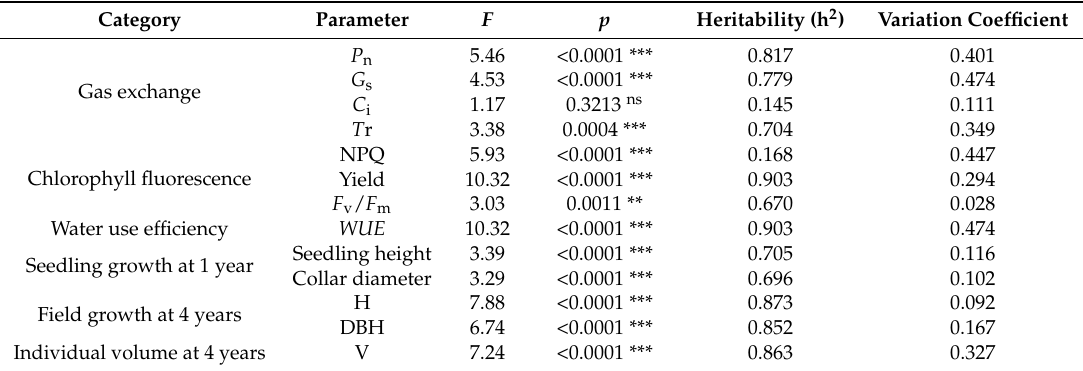
Table 2. Variance analysis (ANOVA) of gas exchange, chlorophyll fluorescence, water use efficiency, and growth parameters among teak clones.